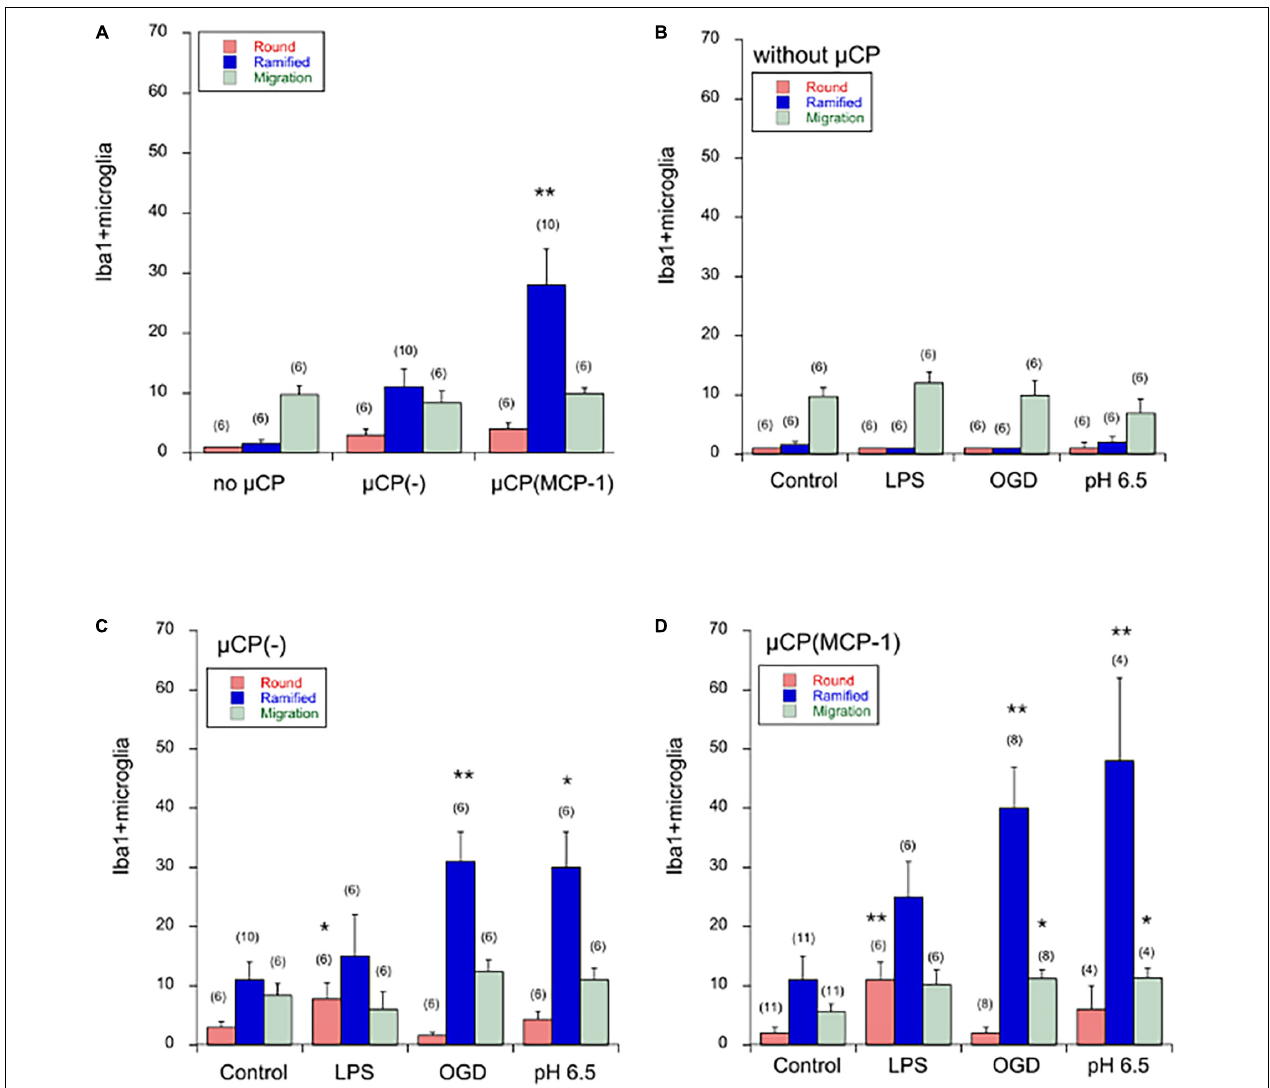
FIGURE 4 | Quantification of Iba1+ microglia in the microcontact printing ( µ CP) assay. Brain slices were prepared, cultured for 4 days in normal slice medium and then treated for 3 days without (minus, control), or with lipopolysaccharide (LPS) or oxygen-glucose deprivation (OGD) or acidosis (pH = 6.5), and then incubated for further 2 weeks in normal slice medium. Slices were then analyzed for microglial Iba1 by immunostainings, and quantified. Panel (A) compares microglia cultured without any µ CP or cultured on µ CP without any stimulus or cultured on µ CP loaded with monocyte-chemoattractant protein-1 (MCP-1). The three different treatments are compared in cultures without any µ CP [Panel (B) ], in cultures with µ CP without stimulus [Panel (C) ] and in cultures with µ CP loaded with MCP-1 [Panel (D) ]. The number of round (red bars) and ramified (blue bars) Iba1+ microglia as well as the length of migration (green bars) was counted on a length of 300 µ m on both sides of the two slices and the values of four measurements averaged. For better graphical illustration of the data, the migration distance was multiplied by a factor of 10. The number of analyzed mice is given in parenthesis. Values are given as mean ± SEM cells per 300 µ m or mm length. Statistical analysis was performed by ANOVA with a Fisher’s LSD post hoc test vs. the control group (* p ≤ 0.05; ** p ≤